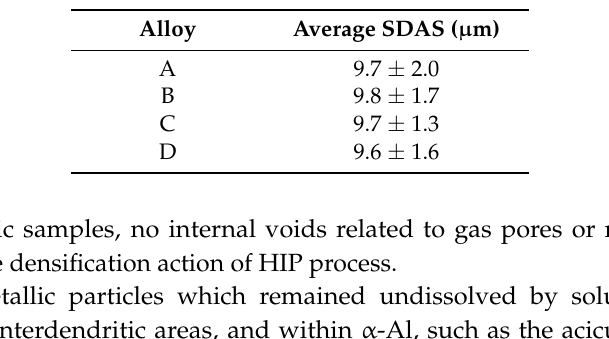
Figure 2. Low-magnification optical images showing the microstructure of alloys ( a ) A; ( b ) B; ( c ) C and ( d ) D, consisting in α -Al dendrites, Al-Si eutectic and intermetallic particles. Table 2. Average SDAS value calculated on T6 alloys.